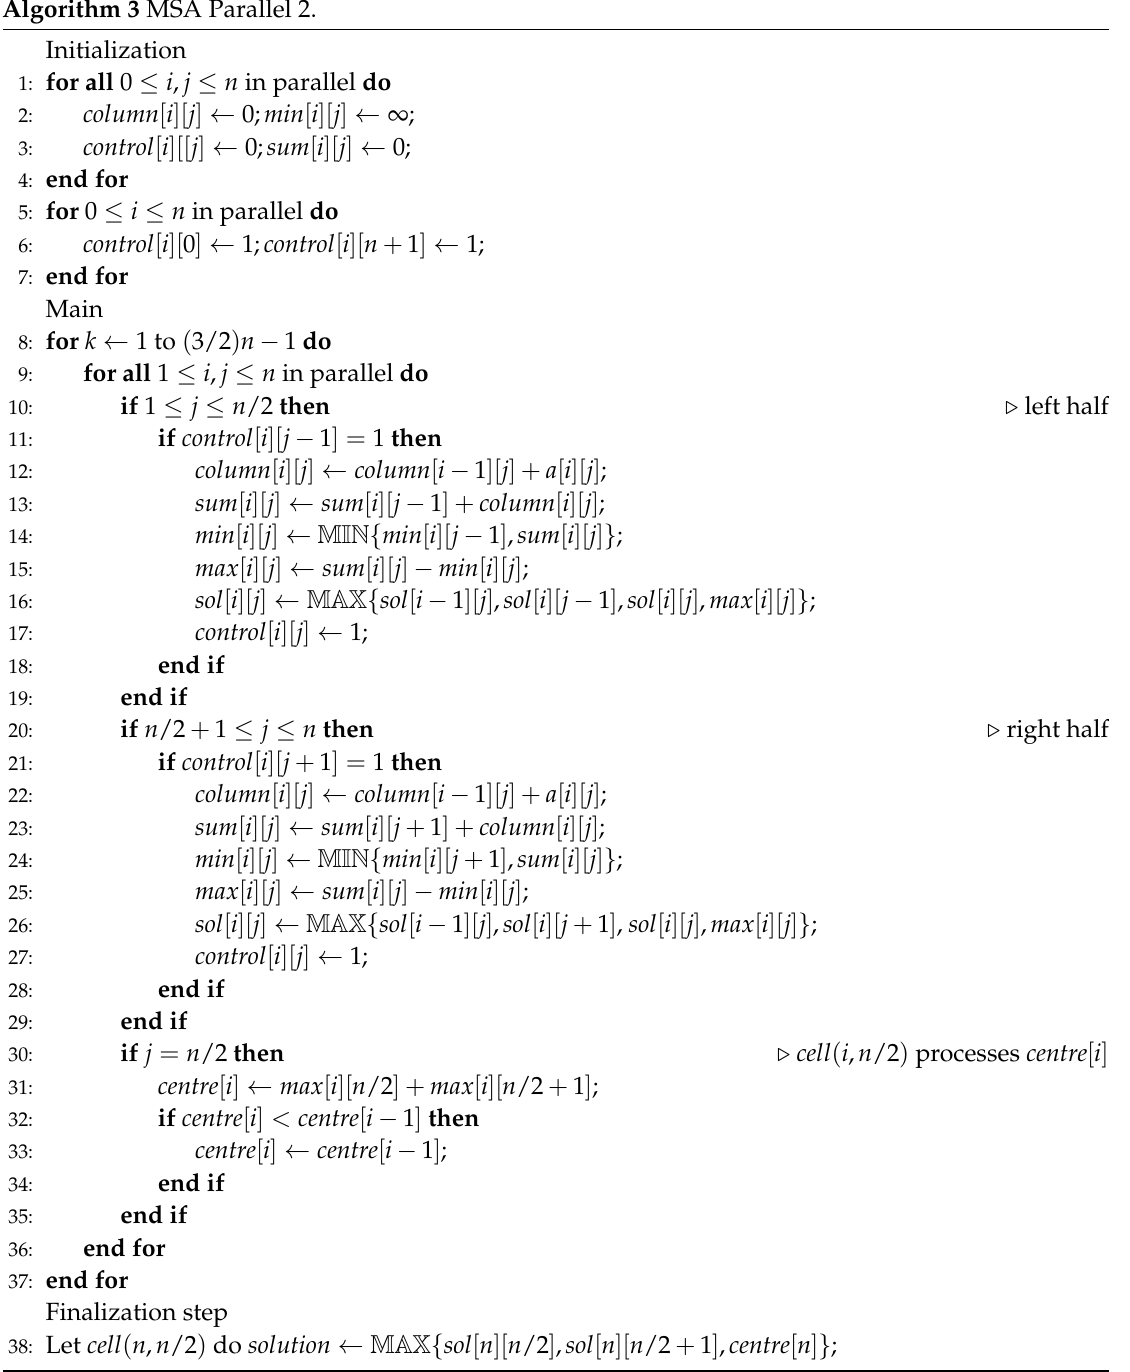
Algorithm 3 MSA Parallel 2.